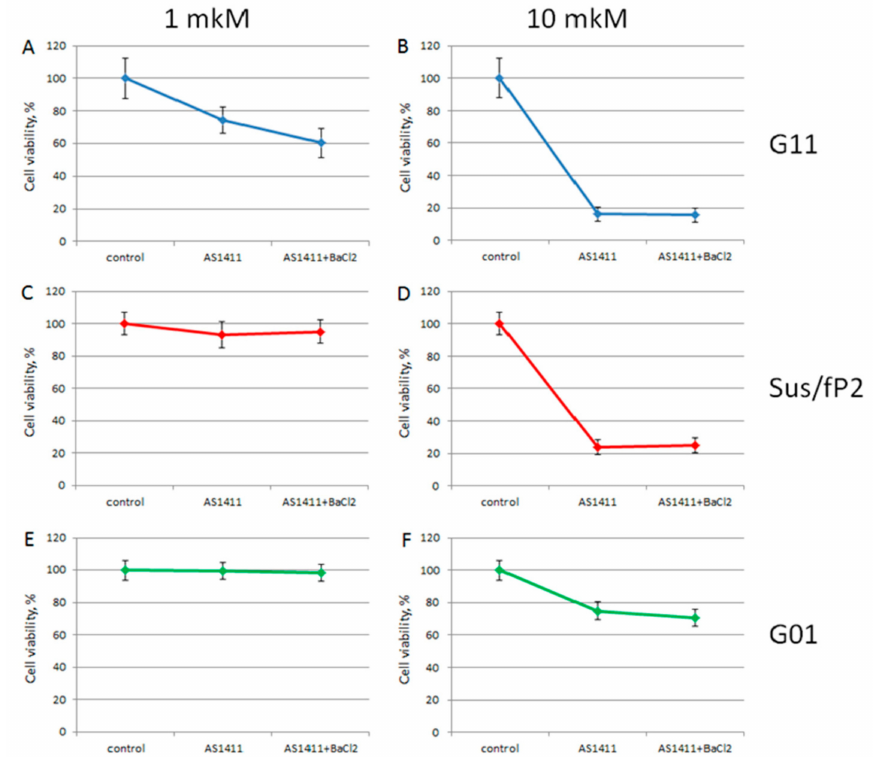
Figure A5. MTT assay data on cell viability of three patient primary glioma cell cultures after treatment with AS1411+Ba 2+ at 1 and 10 µ M, for 72 hrs. Patient primary glioma cell cultures: G11 ( A , B , blue), Sus/fP2 ( C , D , red), G01 ( E , F , green). Data are shown as (mean +/ − SD). Patient data are in Table 1.